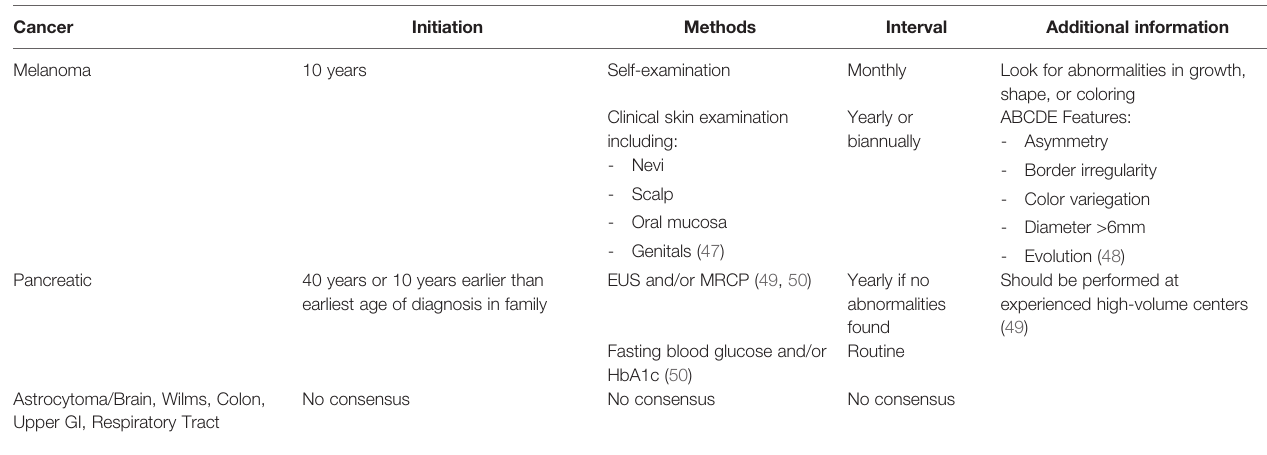
TABLE 2 | Summary of surveillance recommendations for CDKN2A